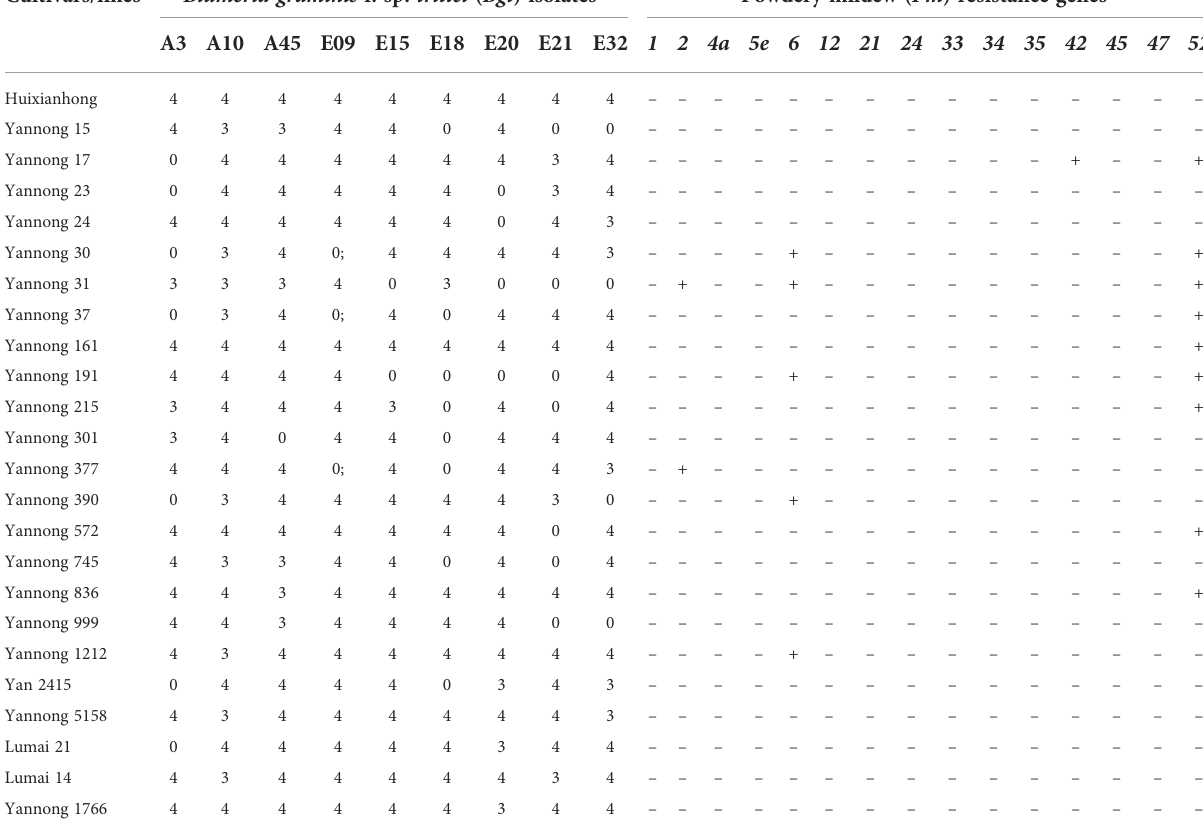
TABLE 3 Seedling infection types to Blumeria graminis f. sp. tritici and resistance genes detected with molecular markers.